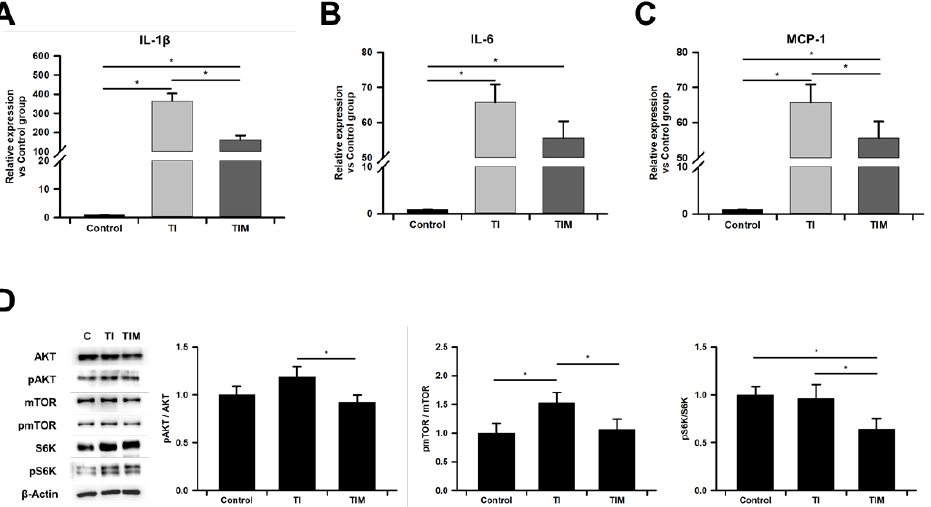
Figure 4. MIT-001 improved senescent phenotypes of hPD-MSCs. ( A – C ) Real-time qPCR results demonstrating the representative SASP expression levels of IL-1 β , IL-6, and MCP-1. ( D ) Western blot analysis and phosphorylation ratios determined from the band intensities of anti-pAKT/anti-AKT, anti-pmTOR/anti-mTOR, anti-pS6K/anti-S6K, and the housekeeping protein β -actin in the control, TNF- α /IFN- γ -exposed, and TNF- α /IFN- γ with MIT-001-treated hPD-MSCs. C: control, TI: TNF- α + IFN- γ , TIM: TNF- α + IFN- γ + MIT-001. Data are presented as the mean ± SEM ( n = 3). Statistical significance was determined by a one-way ANOVA. * p < 0.05.